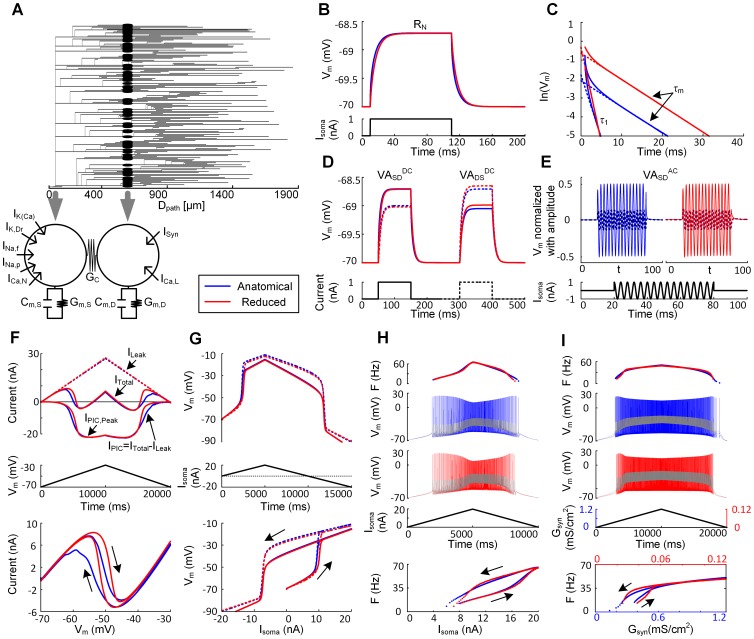
Comparison of the anatomical (blue) and reduced (red) MN model.(A). Reduction of anatomical dendrites. A dendrogram (upper panel) of a MN (i.e. vemoto6 in Methods) with path length (Dpath) from the soma and two compartments (bottom panel) of the reduced model representing the soma/initial segment/axonal hillock (indicated by left arrow) and all points in the narrow band (e.g. mean of 600 µm and standard deviation of 4 µm, right arrow) of dendrites of its original cell. Note that membrane potentials at individual points in the dendrites of the anatomical model were averaged for the purpose of comparison to the reduced model. (B) – (E). Passive dynamics. All five passive parameters (Gm,S = 0.143 mS/cm2, Gm,D = 0.131 mS/cm2, Cm,S = 1.058 µF/cm2, Cm,D = 0.915 µF/cm2, GC = 0.211 mS/cm2) of the reduced model were analytically determined to retain the five system properties measured from the anatomical model: input resistance (RN = 1.29 MΩ) and membrane time constant (τm = 7.2 ms) obtained by peeling analysis at the soma, and three voltage attenuation factors (VASD
DC = 0.76, VADS
DC = 0.75, VASD
AC = 0.27) at Dpath = 600 µm. (B). Time course of membrane potential (Vm) in response to the step current (Isoma) injected to the soma for calculating RN. (C). The semilog plot (solid lines) of transient voltage response at the soma to brief current pulse with smaller amplitude for anatomical than reduced case for τm and τ1 (equalizing time constant) equivalent to the inverse of slope of linear regression (dotted) line fitting the tail of each curve. (D). Time courses of Vm for VASD
DC from the soma (solid lines) to dendrites (dotted lines) and VADS
DC in the opposite direction, in response to DC input (bottom panel) to the soma (solid line) and dendrites (dotted line). (E). Time course of Vm normalized with its amplitude for VASD
AC from the soma (solid line) to dendrites (dotted line), in response to somatically injected AC current (Isoma) with the frequency of 250 Hz. (F), (G). PIC activation with the addition of ICa,L to the dendrites of both models. (F). Time course of effective PIC (IPIC, upper panel) obtained by subtracting leak (ILeak) from total current (ITotal) injected for following the triangular voltage-clamp (Vm, middle panel) at the soma, and ITotal-Vm relationship (bottom panel). (G). Time course of Vm (upper panel) at the soma (solid lines) and dendrites (dotted lines) in response to triangular current clamp at the soma (Isoma, middle panel), and Vm-Isoma relationship (bottom panel). Arrows indicate the ascending and descending phase of triangular voltage and current clamp. Maximum conductance (GCa,L) for ICa,L was 1.37 mS/cm2 for the anatomical and 0.124 mS/cm2 for the reduced case. (H), (I). Cellular excitability with the addition of INa,f, INa,p, IK,Dr, ICa,N and IK(Ca) to the soma of both models. (H). Instantaneous firing rates (F, upper panel), time course of Vm (blue & red for the soma, and gray for the dendrite) in response to triangular current stimulation (Isoma) to the soma, and F-Isoma curve (bottom panel). Maximum conductances for the active currents in the anatomical case were GNa,f = 0.71 [S/cm2], GK,Dr = 0.23 [S/cm2], GCa,N = 0.01 [S/cm2], GK(Ca) = 0.0258 [S/cm2] at the soma, GNa,f = 2.7 [S/cm2], GNa,p = 0.033*10−3 [S/cm2], GK,Dr = 0.17 [S/cm2] at the initial segment and axon hillock, and GCa,L = 1.37 [mS/cm2] in the dendrites. For the reduced model, GNa,f = 26.75 [mS/cm2], GNa,p = 0.00086 [mS/cm2], GK,Dr = 6.2 [mS/cm2], GCa,N = 0.008 [mS/cm2], GK(Ca) = 0.54 [mS/cm2] at the soma and GCa,L = 0.124 [mS/cm2] at the dendrite. (I). F, Vm (blue & red for the soma, and gray for the dendrite) in response to triangular variation of the maximum conductance (Gsyn) for the synaptic receptors positioned at all points at Dpath = 600 µm, and F-Gsyn curve. Arrows indicate the ascending and descending phase of Gsyn.